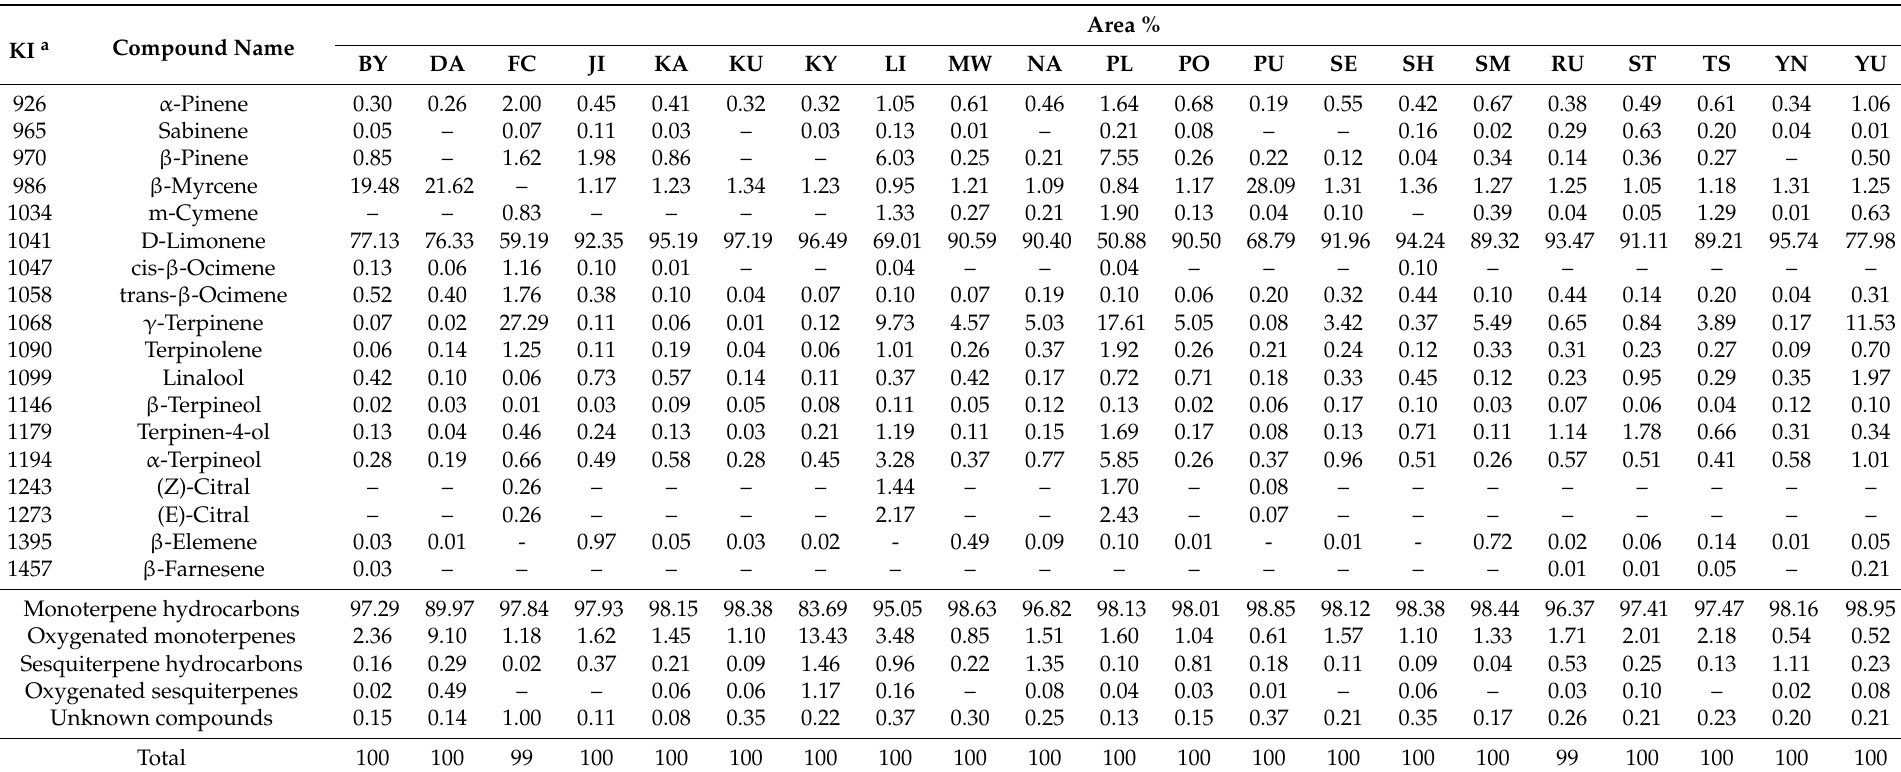
Table 1. Chemical compositions of essential oil from citrus cultivar